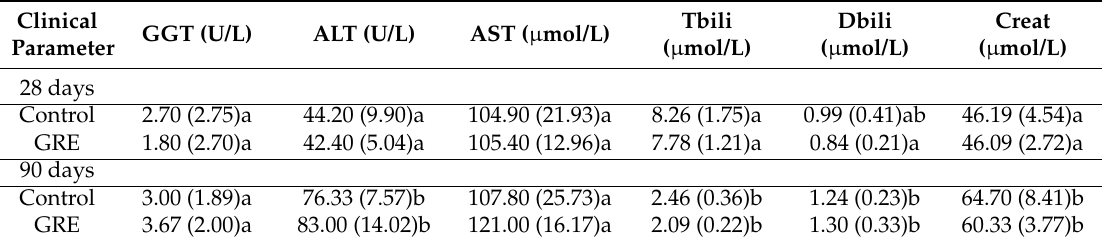
Table 3. Serum clinical biochemical indicators of liver function after dietary consumption of GRE a by male Fischer rats for 28 and 90 days.